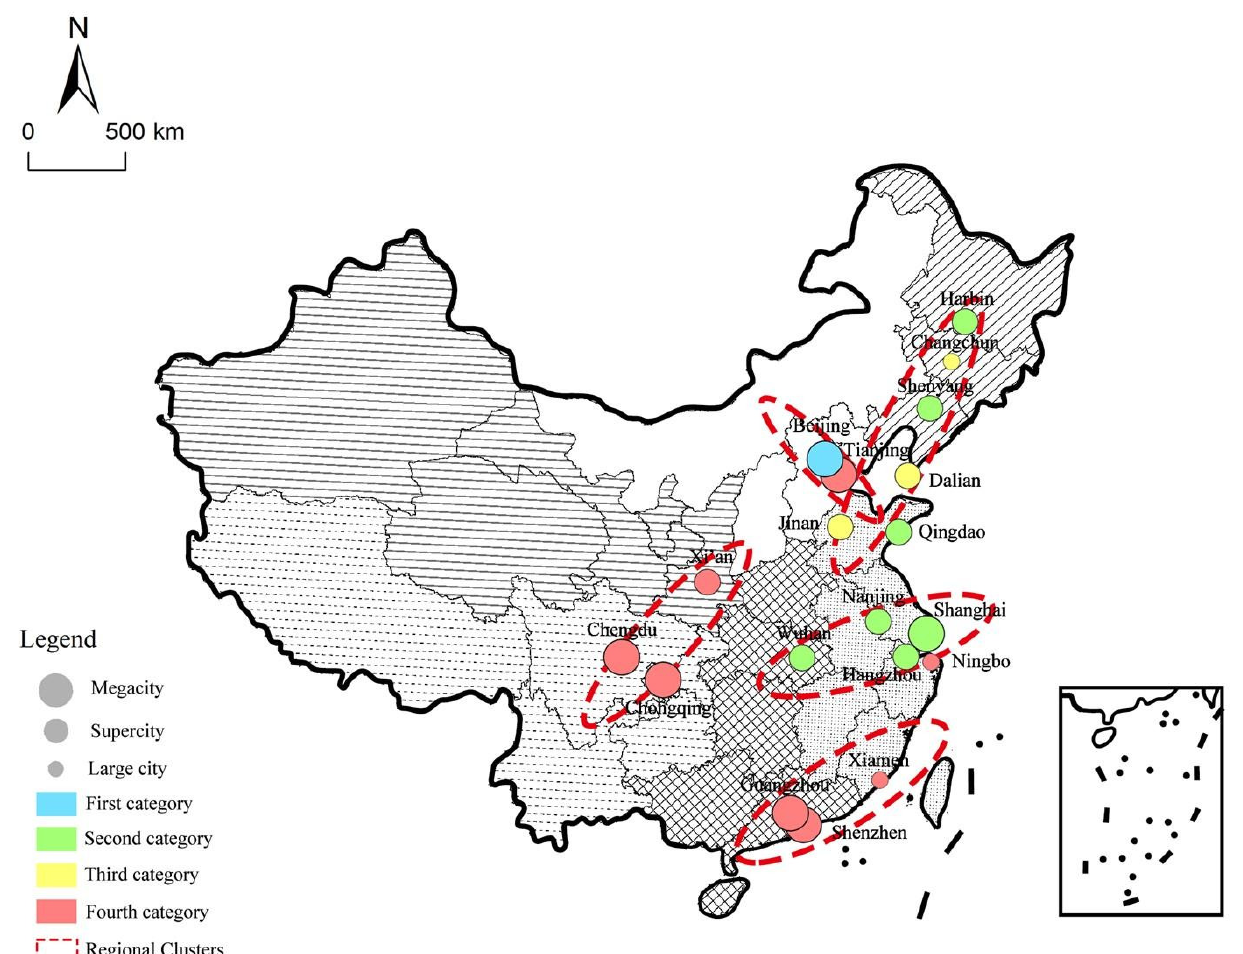
Figure 8. Regional horizontal spatial distribution results. (Source: repainted by the author, http: //bzdt.ch.mnr.gov.cn/browse.html?picId=%224028b0625501ad13015501ad2bfc0002%22, accessed on 26 November